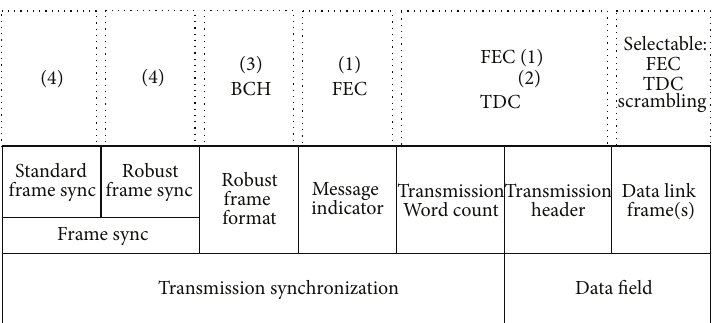
Figure 3: Transmission frame structure with embedded COMSEC.